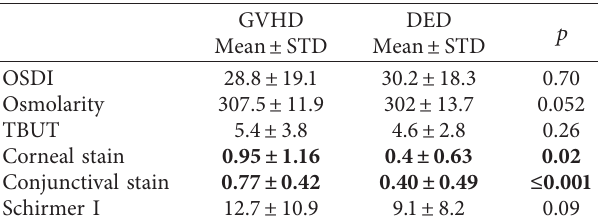
Figure 1: Receiver operating characteristic (ROC) curve and area under the curve for the conjunctival expression of Matrix Met- alloprotease-9 in Graft versus Host Disease and Dry Eye patients at the early stage of their Table 1: Clinical tests performed.